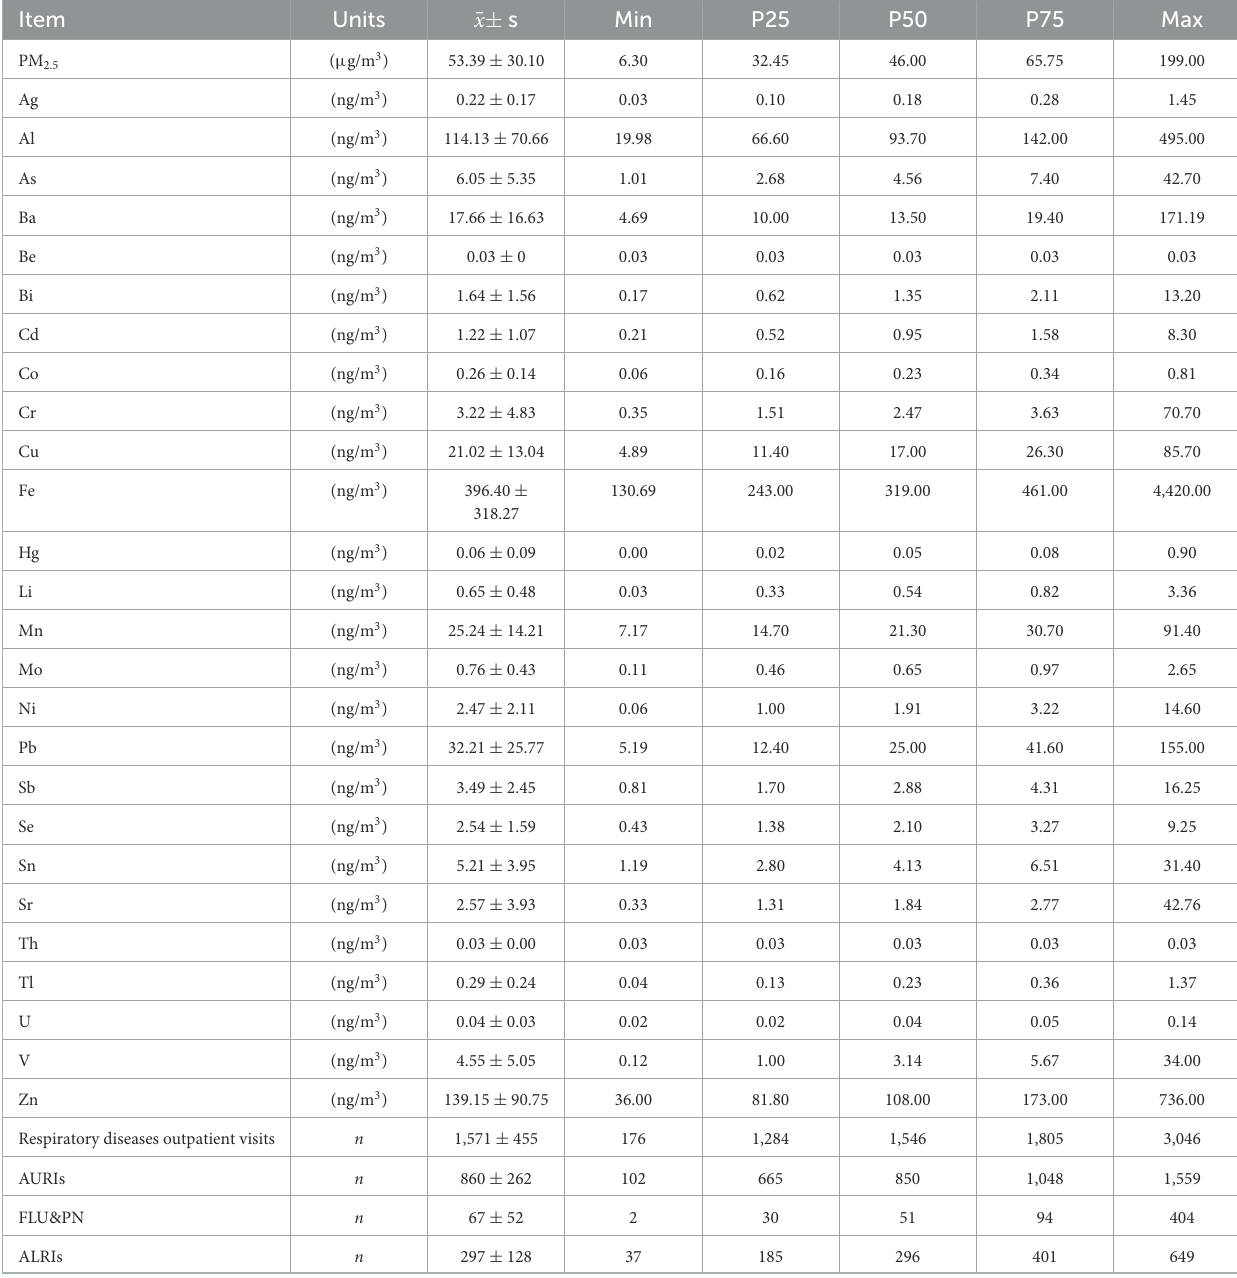
TABLE 2 Daily means and standard deviations of PM 2.5 concentration, PM 2.5 -bound metal concentrations, and pediatric respiratory outpatient visits from 2017 to